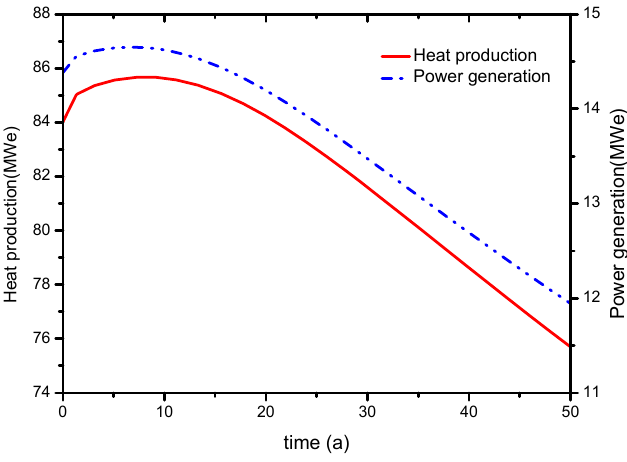
Figure 6. Evolution of heat production and power generation.